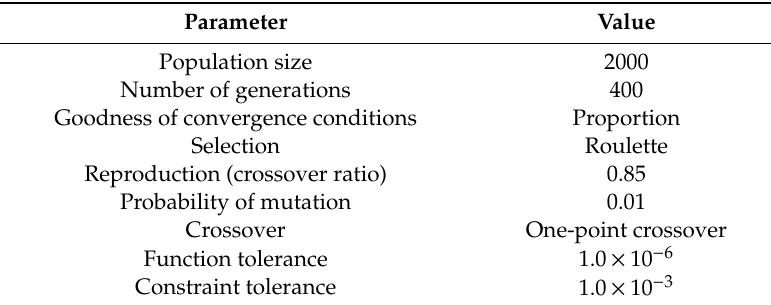
Table 7. Genetic algorithm parameters.